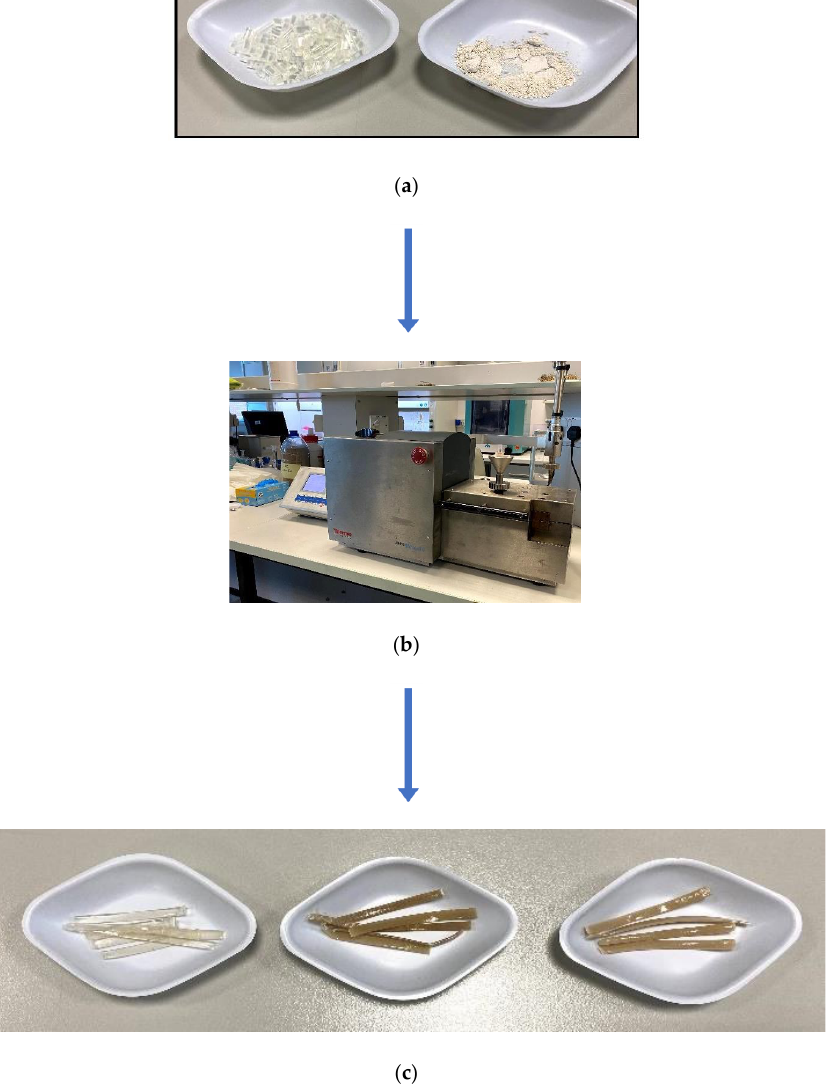
Figure 6. Material processing: ( a ) Shredded PLA and ground silica; ( b ) twin-screw extruder; ( c ) chopped extruded filament samples.